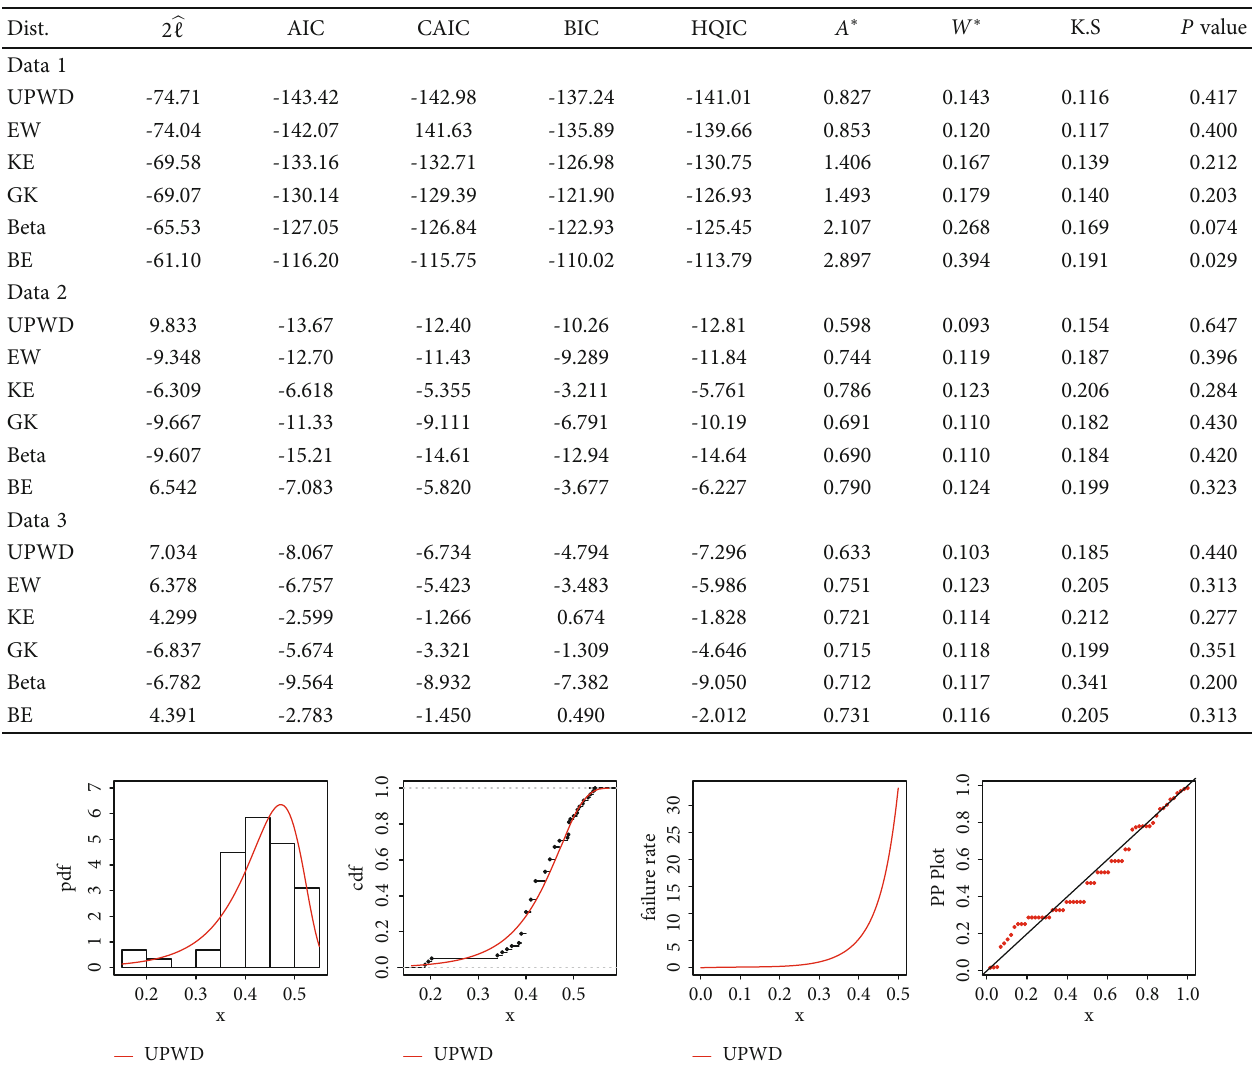
Figure 12: Graphical illustration of estimated pdf, cdf, failure rate, and P-P for data 1.